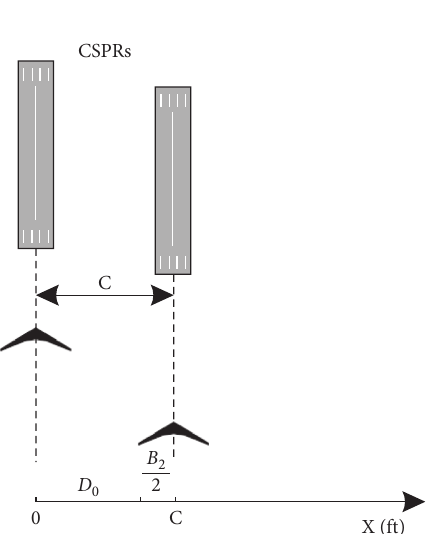
Figure 11: The initial lateral interval of the paired